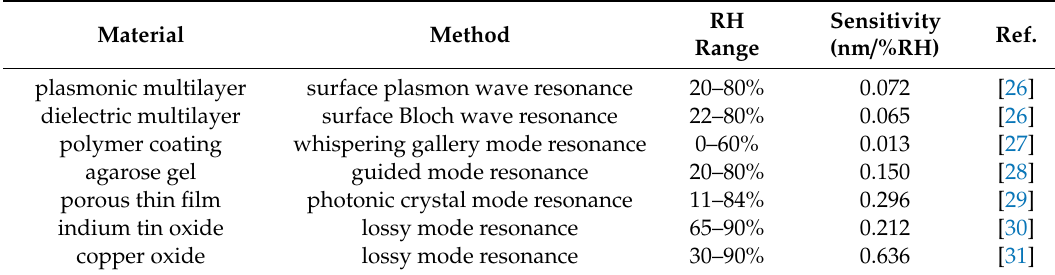
Table 2. Optical RH sensors with different parameters.